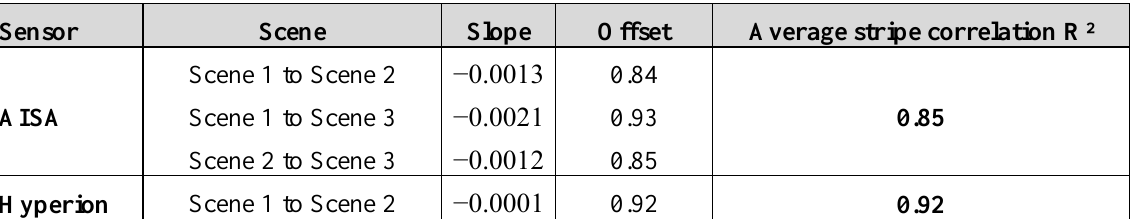
Table 4. Inter-scene striping